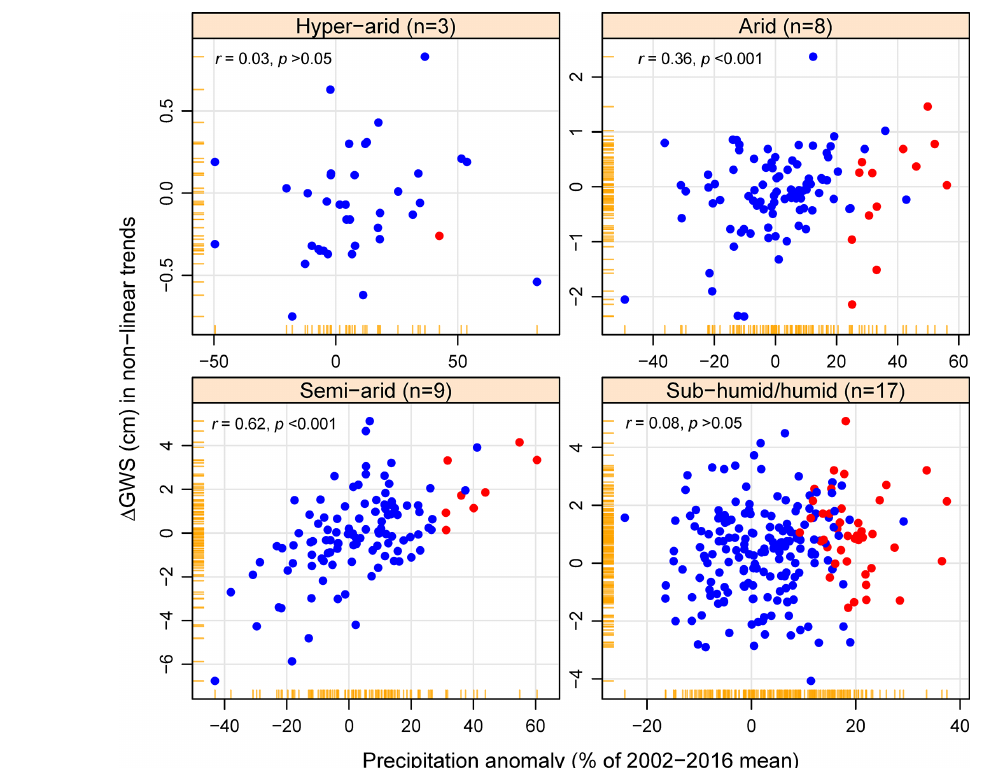
Figure 7. Relationships between precipitation anomaly and annual changes in non-linear trends of GRACE (cid:49) GWS in the 37 large aquifer systems grouped by aridity indices. Annual precipitation is calculated based on hydrological year (August to July) for 12 of these aquifer systems and the other 25 following the calendar year (January to December); the highlighted (red) circles on the scatterplots are the years of statistically extreme ( > 90th percentile; period: 1901 to 2016)